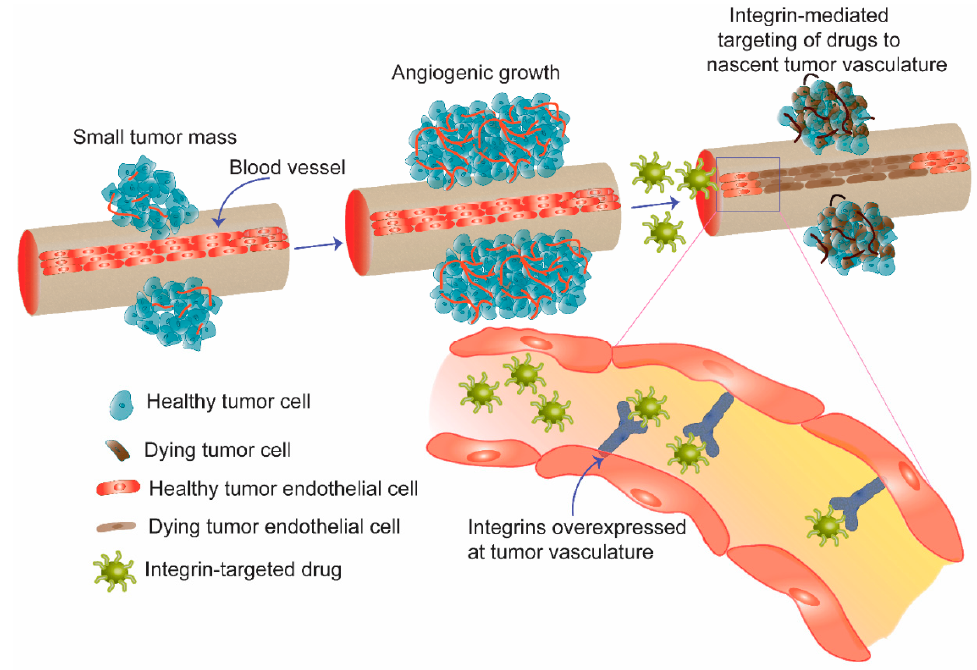
Figure 2. Schematic diagram showing angiogenesis, sprouting of new blood vessels from pre-existing vasculature as an effective mean for tumor growth. In anti-angiogenic therapy, integrin receptors overexpressed on the nascent blood vessels are targeted to deliver drugs and genes selectively to tumor vasculature. Apoptosis of tumor endothelial cells in the vasculature shuts down supply of nutrients to tumor cells and eventually induces killing of bulk tumor.